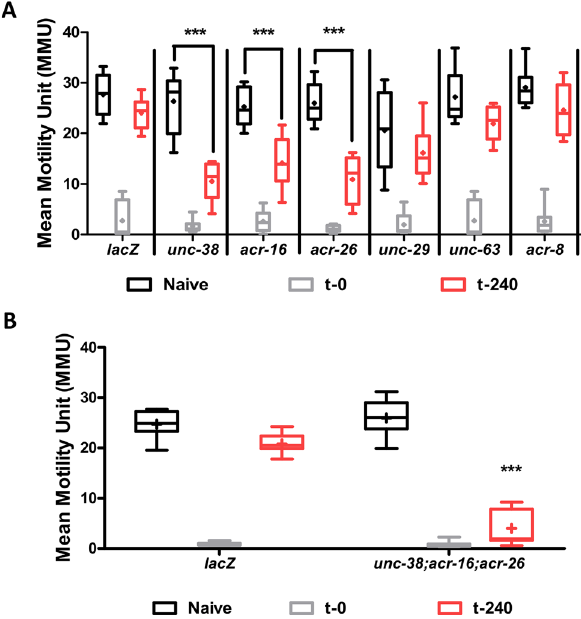
Figure 9. UNC-38, ACR-26 and ACR-16 are required for recovery of motility with 100 µM levamisole treatment (habituation). ( A ) Shows the effect of knockdown on unc-38 , unc-63, unc-29, acr-8, acr-16 and acr-26 on levamisole habituation. Knockdown of unc-38, acr-16 and acr-26 caused significant impairment in levamisole habituation at t-240 min. ( B ) Triple knockdown of unc-38, acr-26 and acr-16 resulted in no reduction in